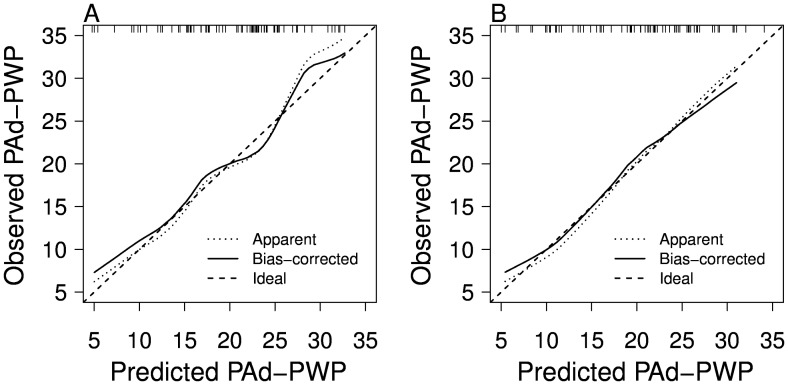
Calibration Model for the Prediction of Pulmonary Artery Diastolic to Wedge Gradient Using Clinical and Echocardiographic Variables.Panel A shows the prediction model calibration curve without inclusion of echocardiographic variables. Panel B shows the model with echocardiographic variables. Accuracy of the predicted PAd-PWP is improved (slope 0.89), especially in the range of PAd-PWP that represents a diagnostic dilemma (~ 5-15mmHg). PAd-PWP = pulmonary artery diastolic to wedge gradient.